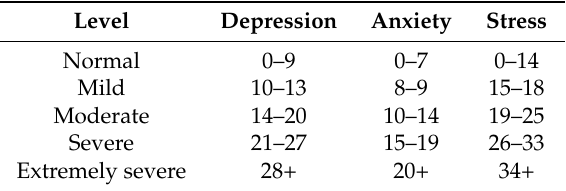
Table 1. Depression Anxiety Stress Scale (DASS 42)